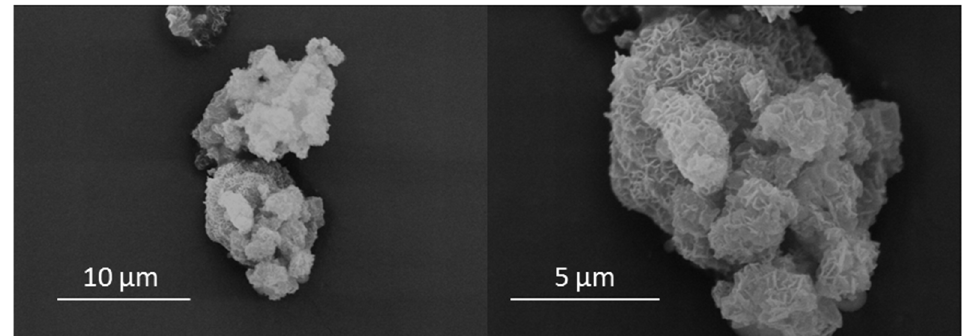
Figure 5. Secondary electron images of the 7-day hydrothermal product (TOB-7).